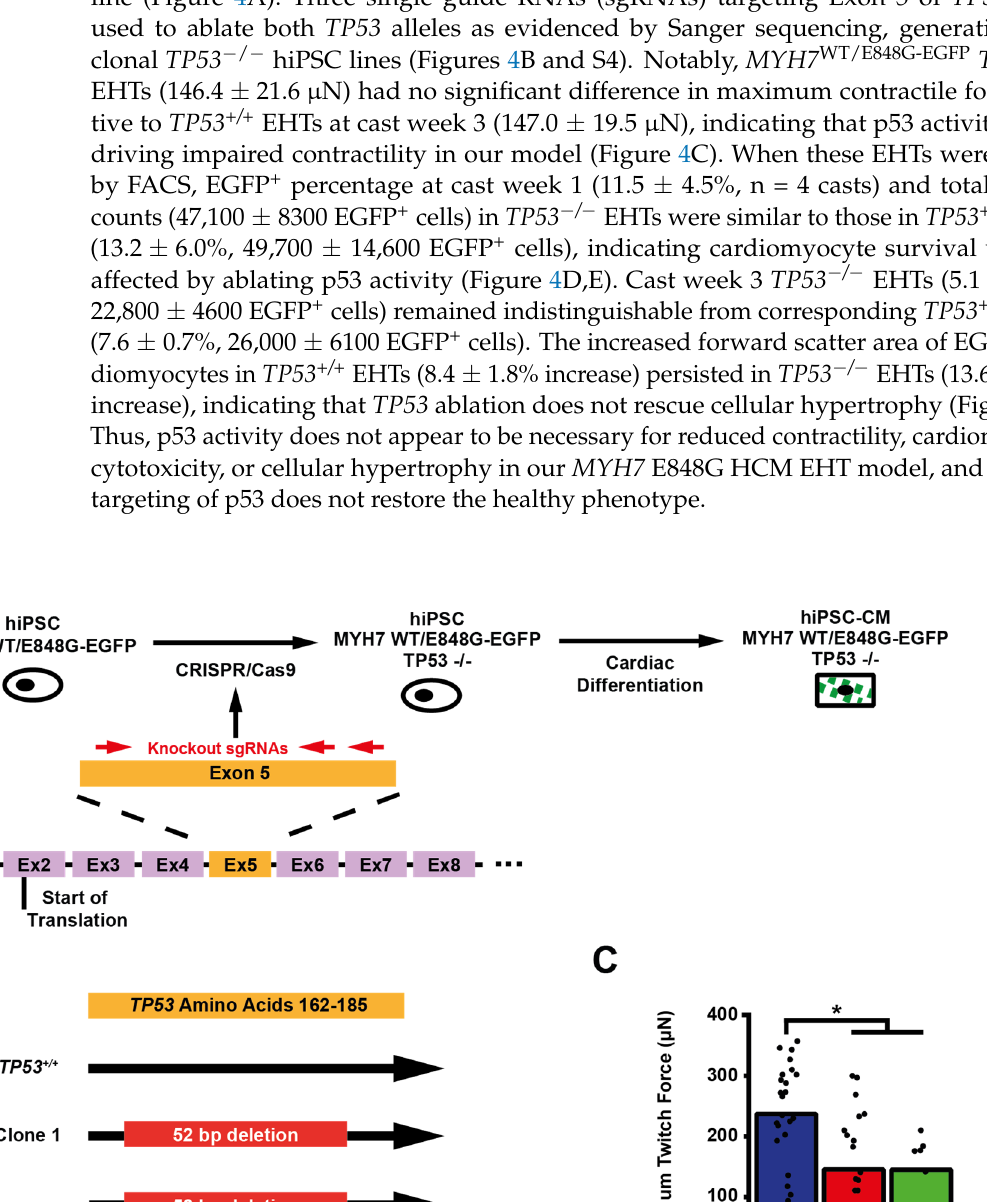
Figure 4. TP53 ablation does not rescue contractile function, hypertrophy, or cardiomyocyte sur- vival in MYH7 E848G-expressing hiPSC-CMs. ( A ) Schematic of CRISPR/Cas9 gene editing strategy